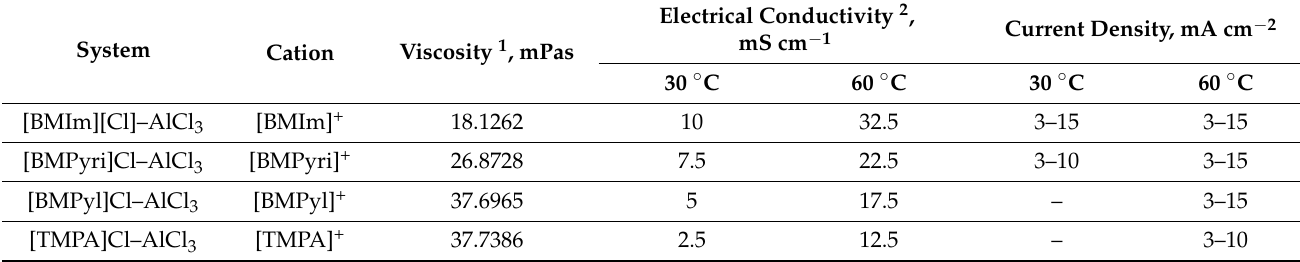
Table 4. Table comparing the viscosity and electrical conductivity of the IL systems reported by Wang et al. [39].